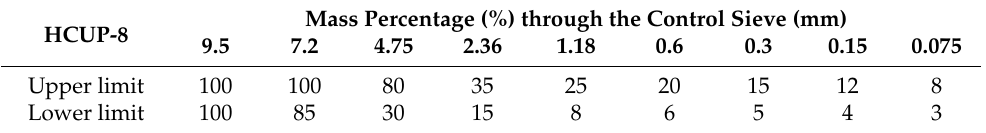
Table 5. Gradation of HCUP-8 mixture.